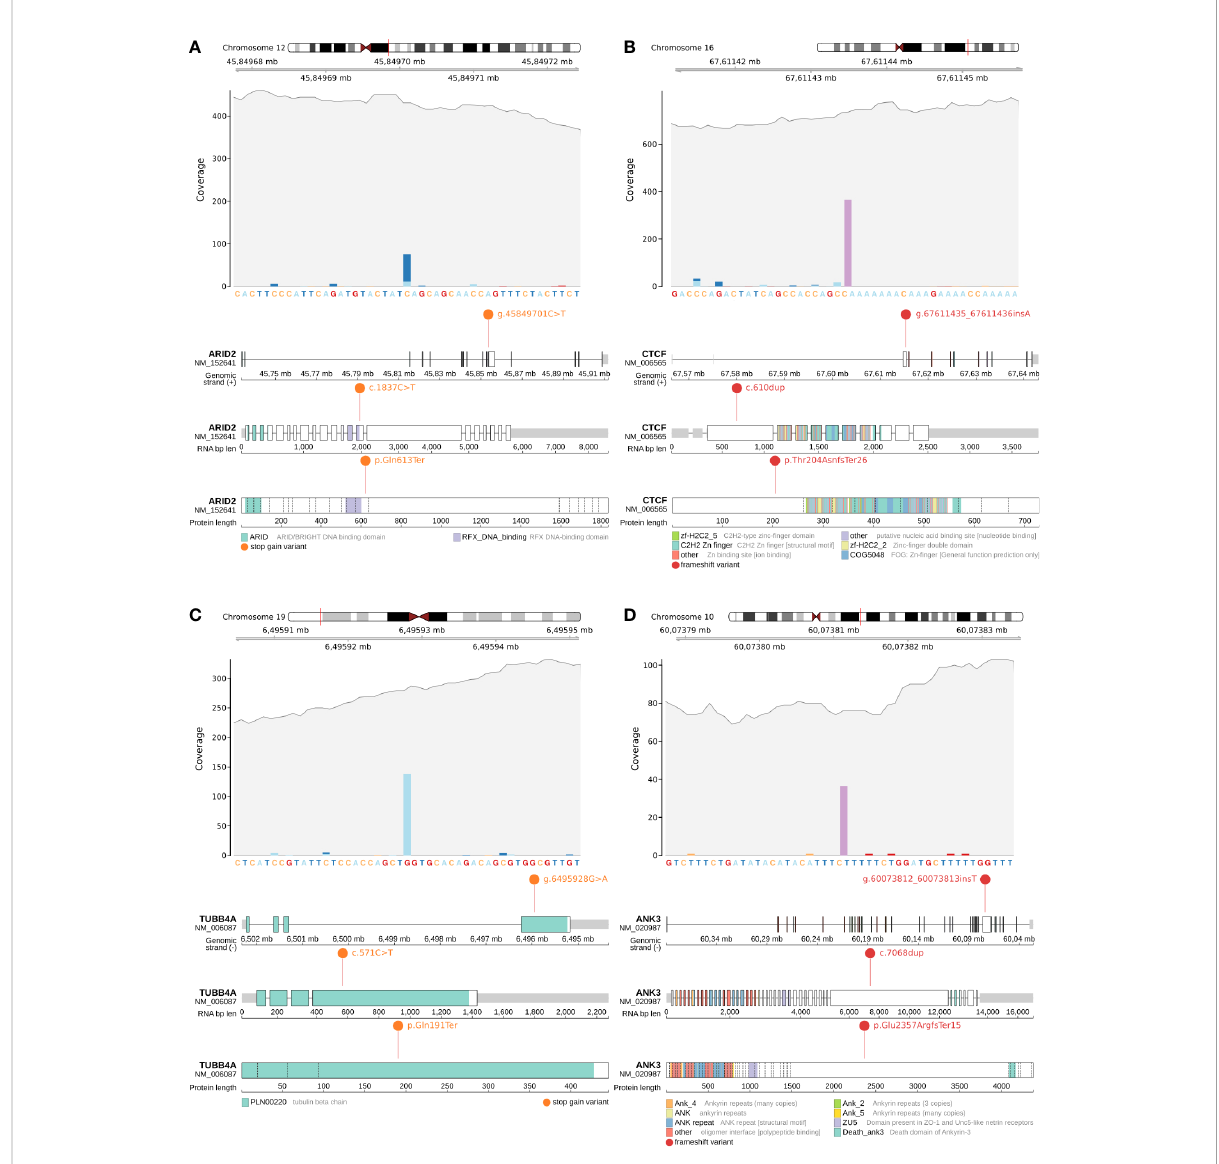
FIGURE 2 Candidate somatic protein truncating variants (GRCh38): (A, B) – coverage and functional effects of PTVs on DNA, RNA and protein level in Patient #1. (A) NC_000012.12:g.45849701C>T in ARID2 (NM_152641:p.Gln613Ter); (B) NC_000016.10:g.67611435_67611436insA in CTCF (NM_006565:p.Thr204AsnfsTer26); (C, D) – coverage and functional effects of PTVs on DNA, RNA and protein level in Patient #2. (C) NC_000019.10:g.6495928G>A in TUBB4A (NM_006087:p.Gln191Ter); (D) NC_000010.11:g.60073812_60073813insT in ANK3